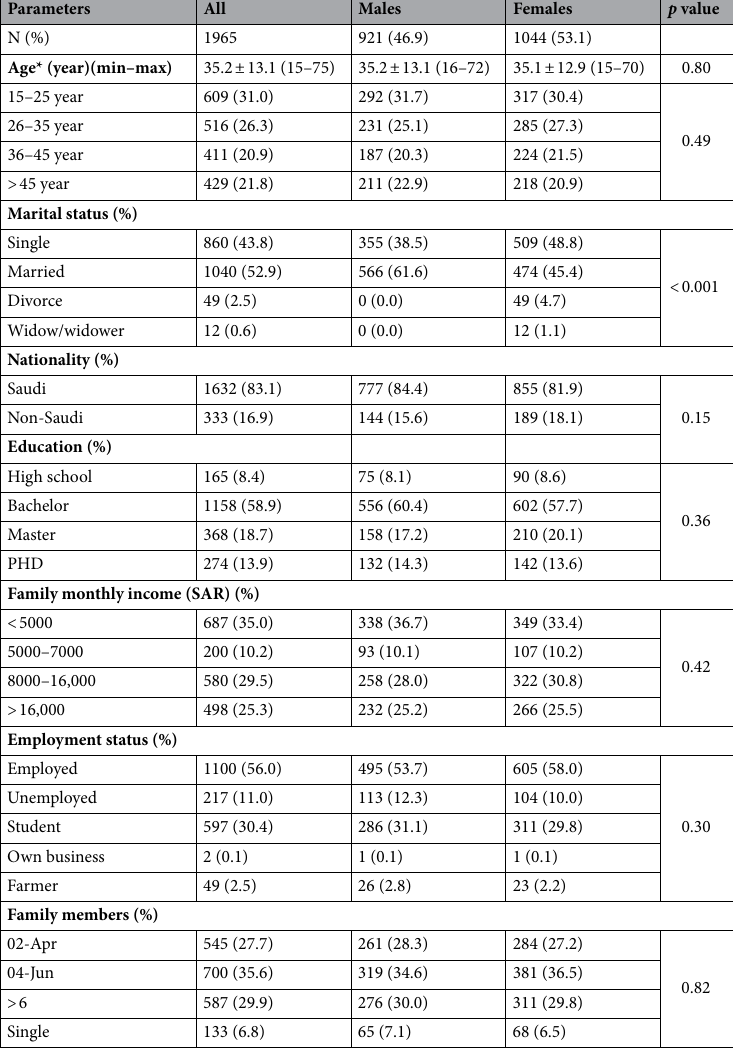
Table 2. Demographic characteristics of participants. Data presented as n (%); *denotes data presented as mean ± standard deviation. p value significant at <